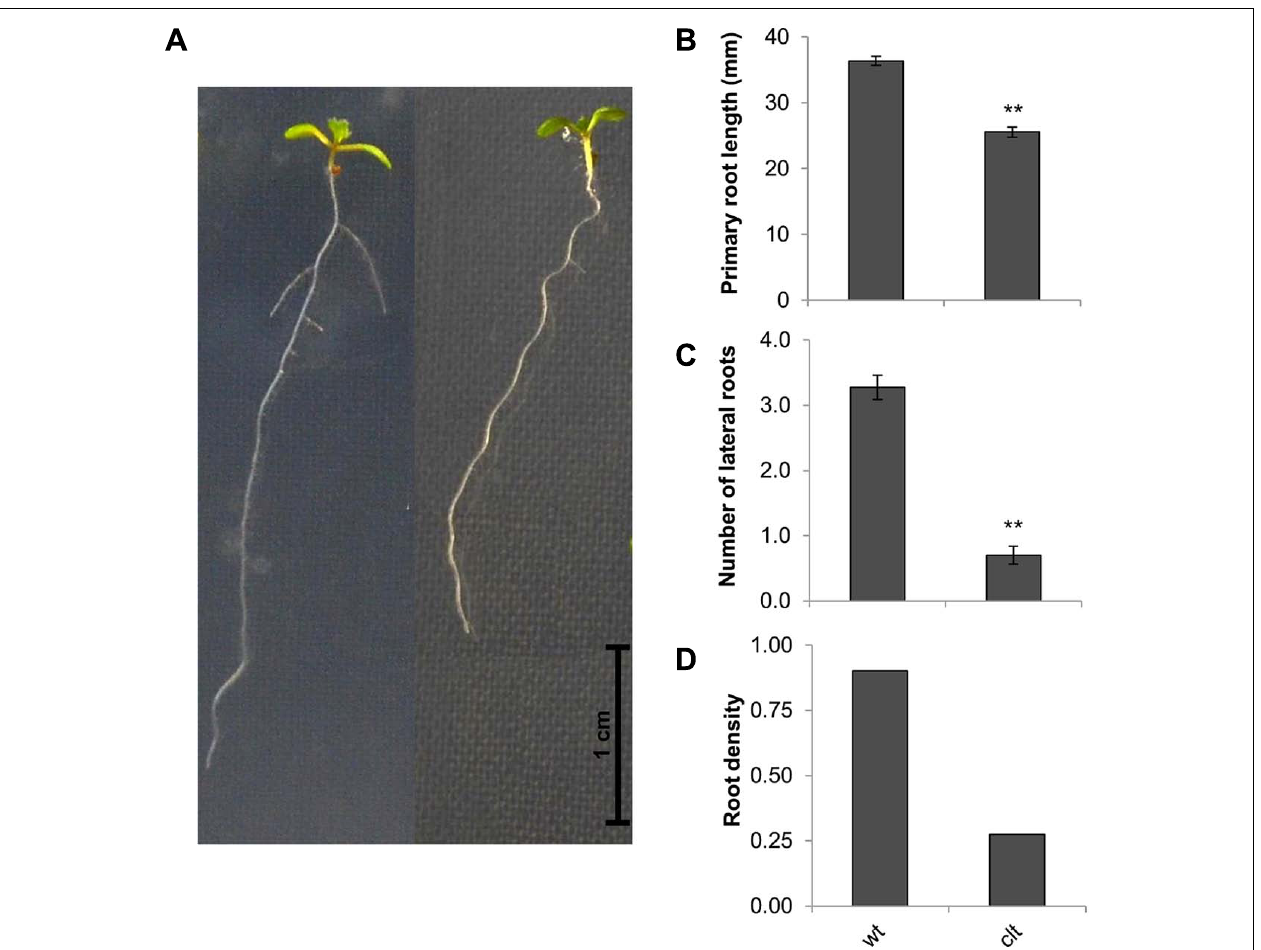
FIGURE 5 | Root architecture the clt1clt2clt3 triple mutants ( clt ) relative to wild type Col-0 (wt). The phenotype of 14-day-old seedlings (A) , primary root length (B) , number of visible lateral roots (C) , and lateral root density (D) .The asterisks indicate significant differences ( p < 0.05;